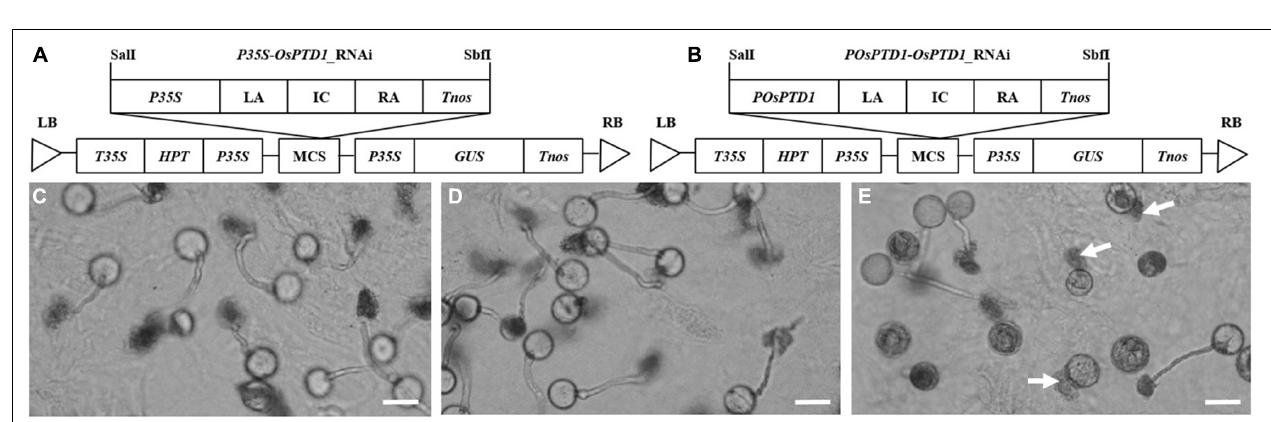
FIGURE 1 | Phenotype of the OsMYB76R gene. (A) The structure of the pP35S - OsMYB76R -OE vector. The left sides of panels (B–E) refer to the color of different organs in Zhongjiu B, and the right sides refer to the color of different organs in a plant that is positive for OsMYB76R overexpression. The traits in panels (B–D) are from T 0 plants. The trait in panel (E) is from the T 1 plant. The left side of the panel (F) is purple wild type R25, and the right side of the panel (F) shows osmyb76 mutant YR25. The arrows point to the purple tissue. Scale bars, 0.2 cm.